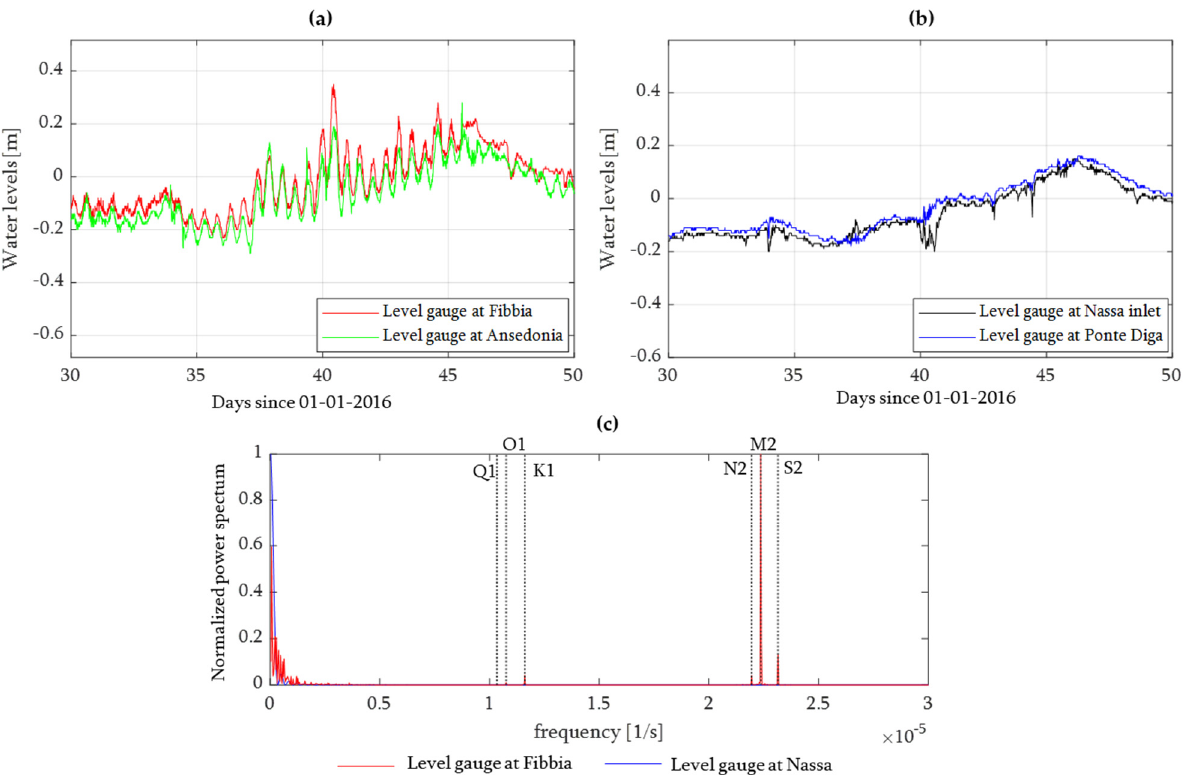
Figure 2. Twenty-days’ time series of water levels measured by the four water-level stations inside the Orbetello Lagoon: Fibbia and Ansedonia ( a ); Nassa and Ponte Diga ( b ). Normalized power spectrum of water level time series recorded at Fibbia (in red) and Nassa (in blue) level gauges, with tidal period components traced in the frequency spectrum as vertical dotted lines: diurnal components, Q1, O1, and K1, and semidiurnal components, N2, M2, and S2 ( c ).